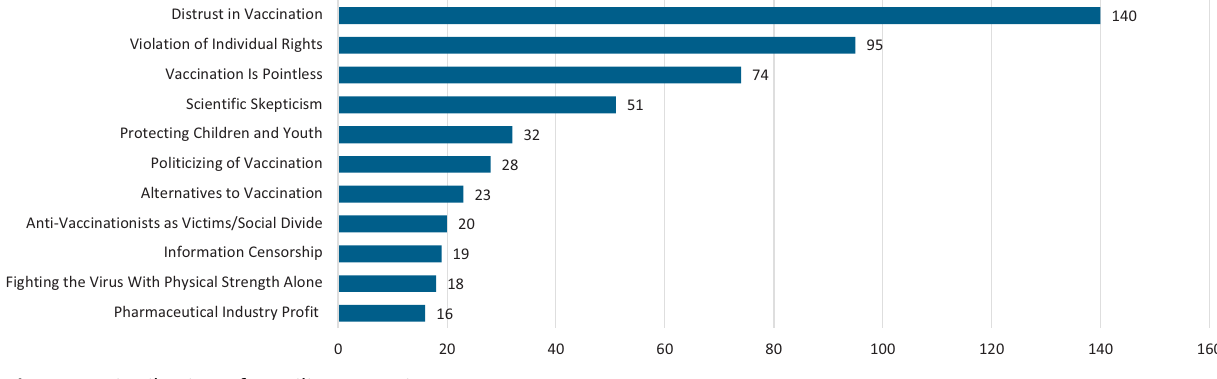
Figure 4. Distribution of Brazilian narratives.